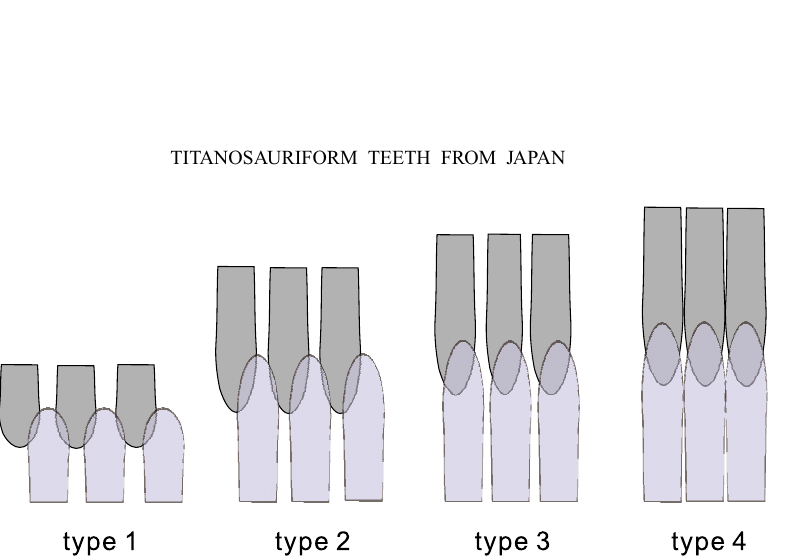
Fig. 1 – Model of wear facet types of the sauropod teeth. Upper and lower teeth are indicated by dark and light colors, respectively. See the differences, among the wear facet types, in presence/absence, positions, and size of the facets that would be made at the area where the upper and lower teeth overlap.